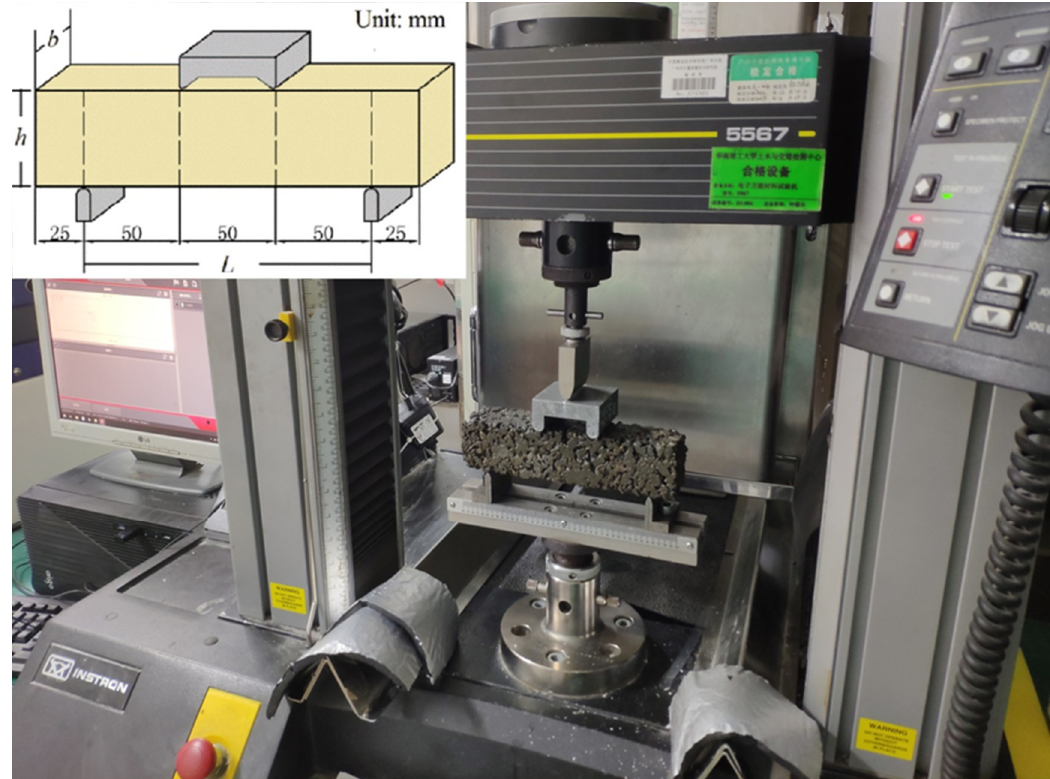
Figure 3. Schematic diagram and photo of the four-point bending test of EPC.